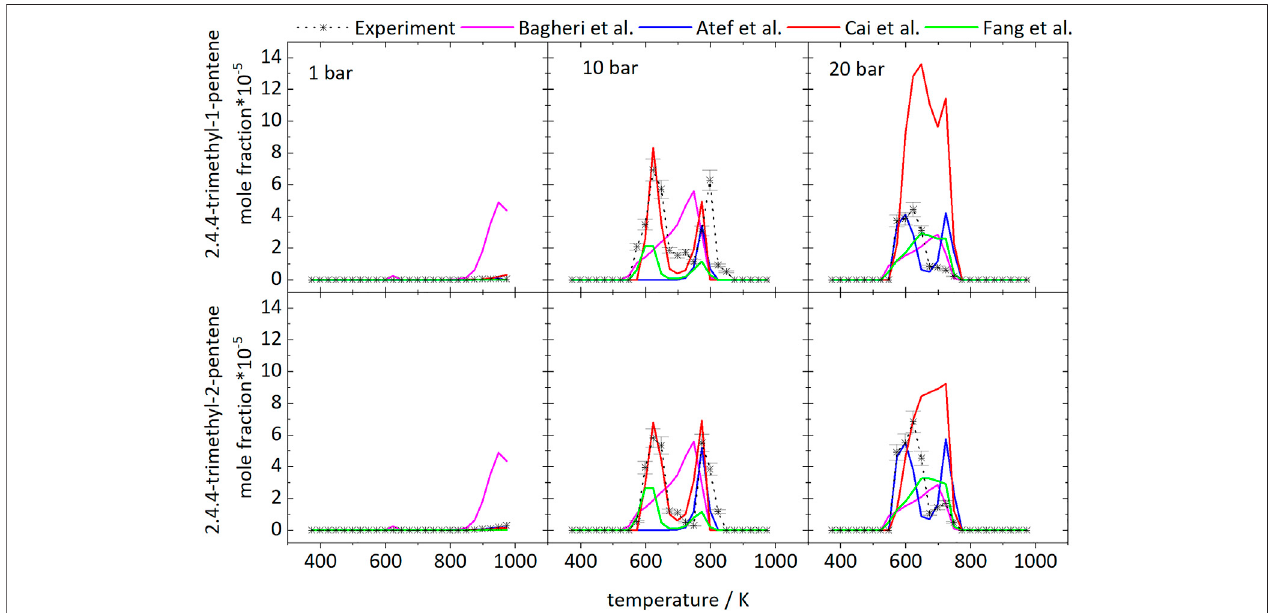
FIGURE 3 | Mole fractions of diisobutylene isomers vs. reactor-temperature at 1, 10, and 20 bar. Dashed lines with symbols and solid lines correspond to experimental and modeling results, respectively.